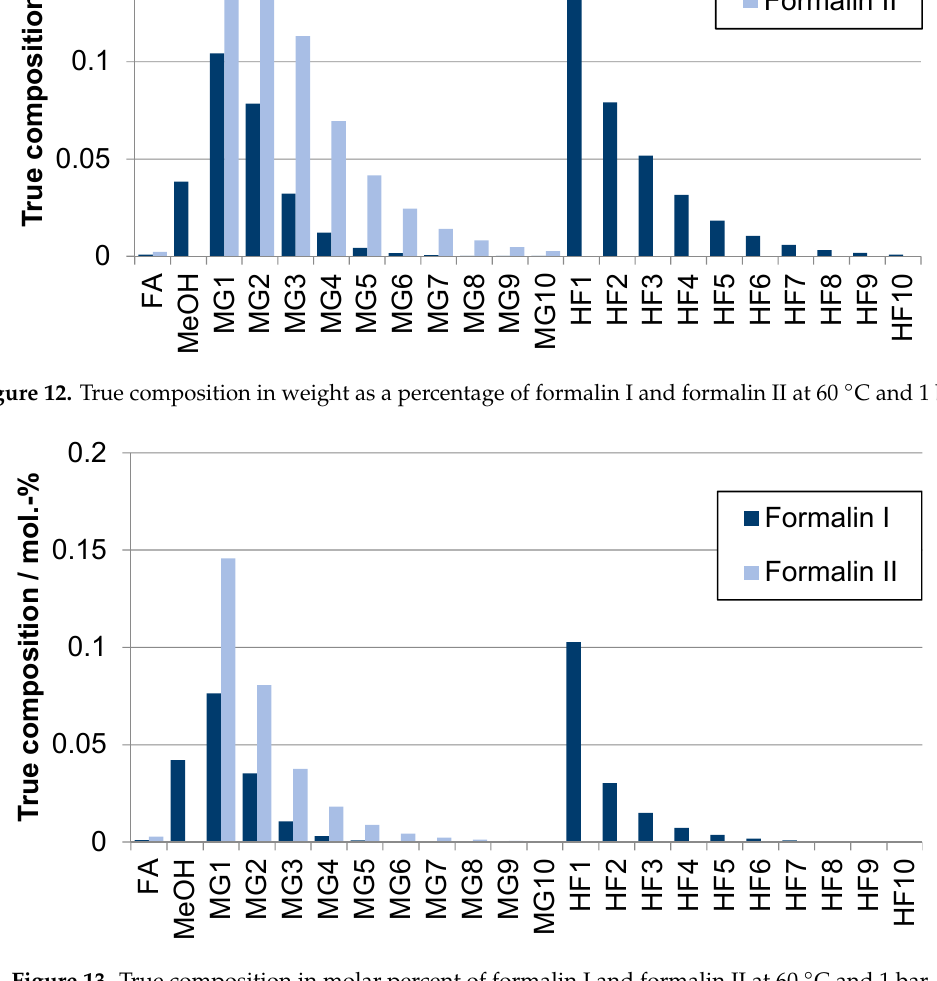
Table 11. Heat demand and excess of formalin synthesis from methanol. HP: high pressure (39.7